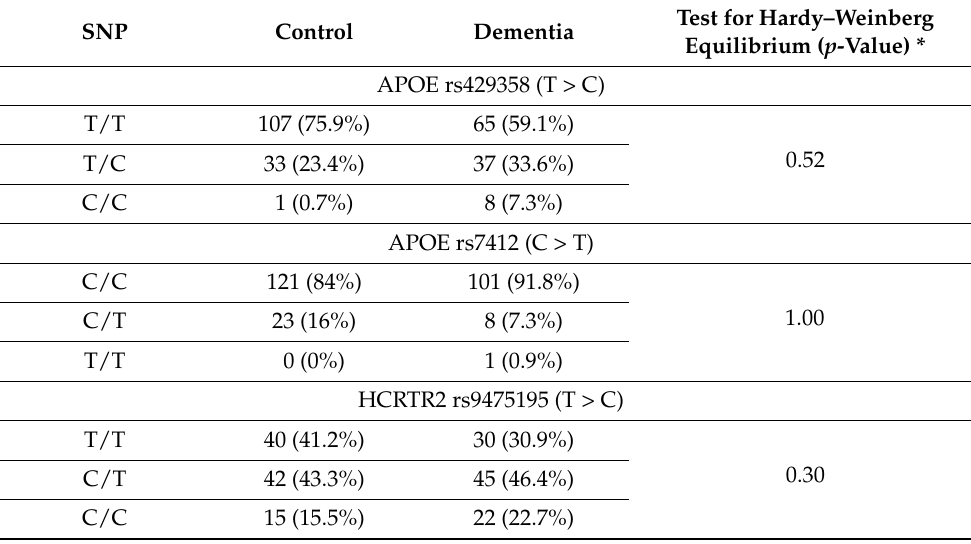
Table 3. Distribution of alleles and test for Hardy–Weinberg